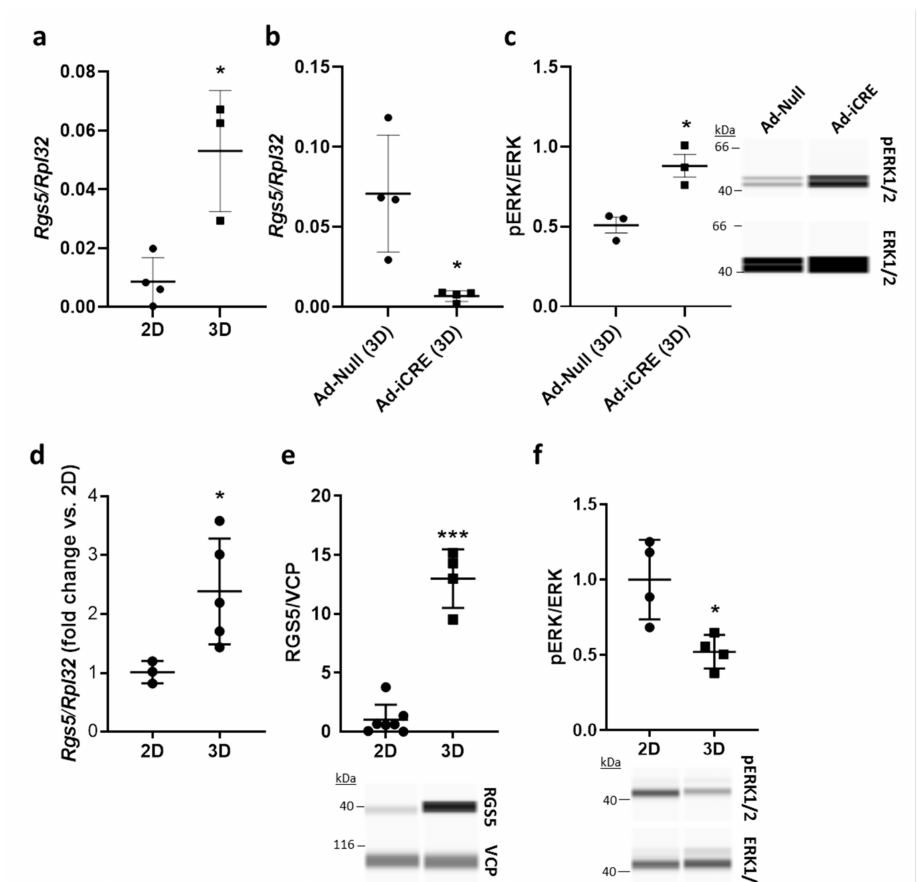
Figure 3. VSMCs cultured in 3D spheroids display higher RGS5 levels and low ERK1/2 activity. ( a – c ) aoSMCs were isolated from the aortas of Rgs5 fl/fl mice and cultured as monolayer (2D) or (* p < 0.05, n = 3–4). ( b ) Knockout of Rgs5 in aoSMCs was achieved by adenoviral transduction